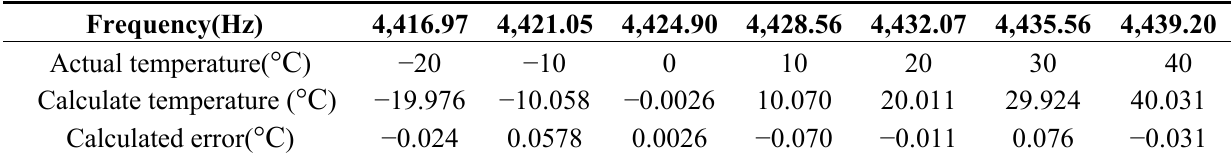
Table 2. Temperature calculated from the frequency and the calculation